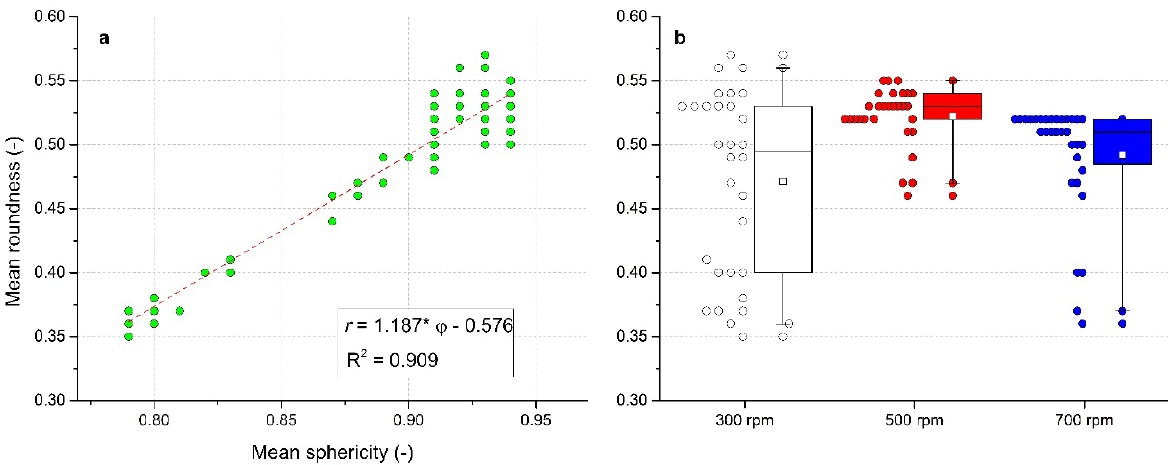
Figure 8. Evaluation of mean roundness. ( a ) Mean roundness relationship on mean sphericity, ( b ) box charts of mean roundness for impeller speeds 300, 500, and 700 rpm.